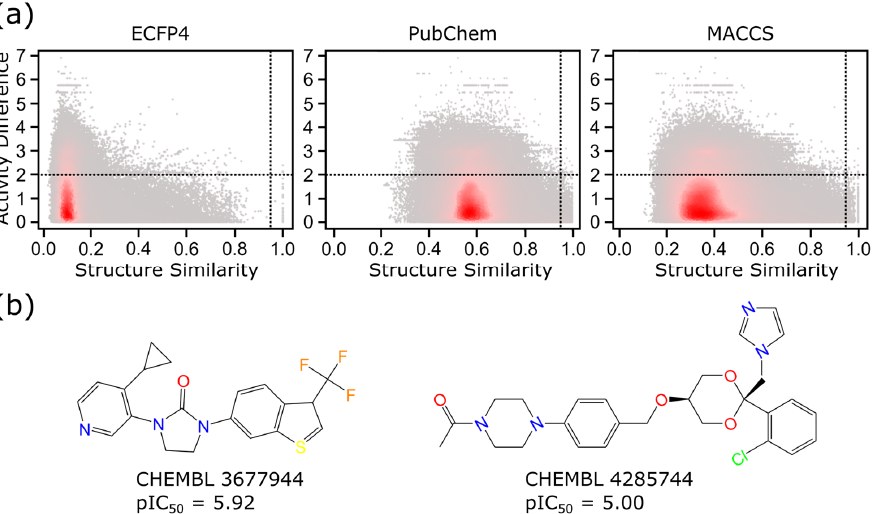
Figure 5. Structure-activity landscape of nonsteroidal inhibitors. ( a ) SAS maps of nonsteroidal molecules with three different fingerprints. Regions with densely populated molecular pairs are colored in red, while less populated regions are colored in gray. The dashed lines outline the boundaries for the activity difference and the structure similarity. Any pairs appearing in the right upper quadrant were identified as ACs. ( b ) Maximum common AC generators from the PubChem and MACCS fingerprints.